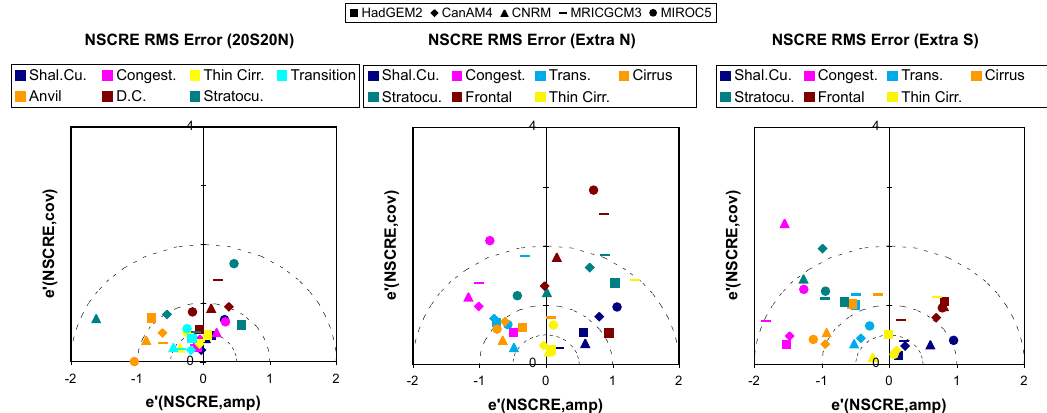
Figure 3. Centred rms error diagrams of the seasonal variation of NSCRE of cloud regimes in (a) 20 ◦ S–20 ◦ N, (b) northern extra-tropics beyond 20 ◦ N, and (c) southern extra-tropics beyond 20 ◦ S. Colours distinguish cloud regimes. Marks distinguish models. The dotted lines are contours of the magnitude of s i (NSCRE). The x -axis shows the contribution of amplitude error, while the y -axis shows the contribution of pattern errors in the time variation. Reprinted from Tsushima et al.